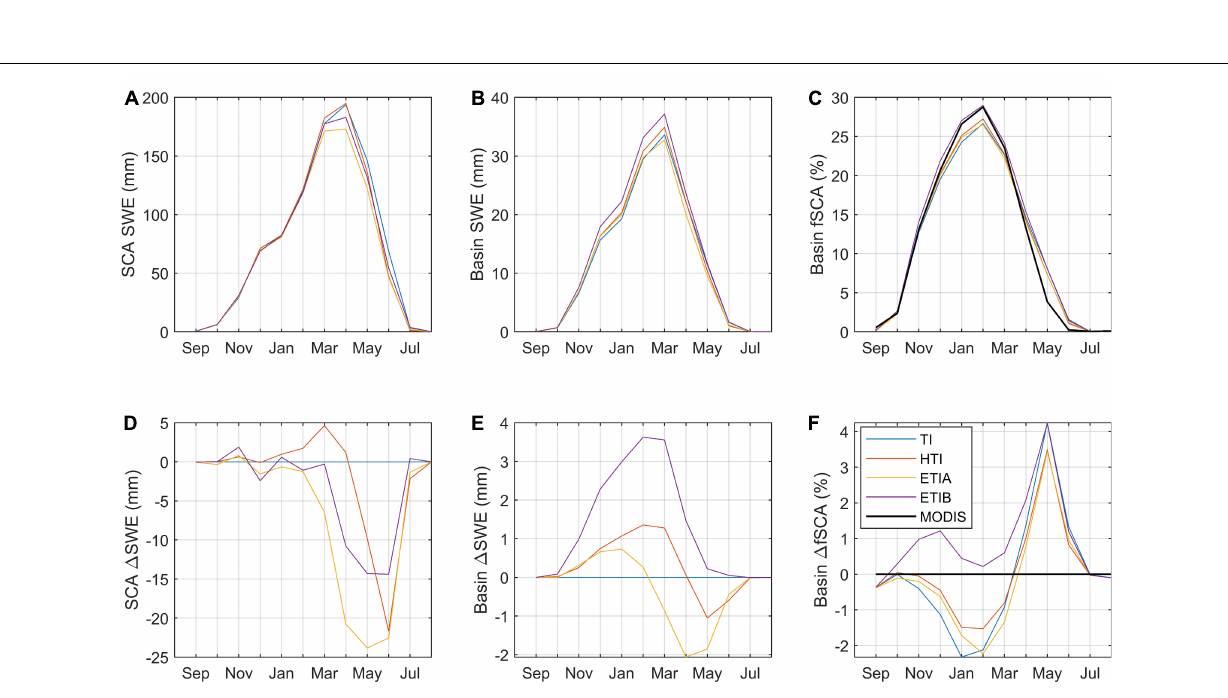
Frontiers in Earth Science |